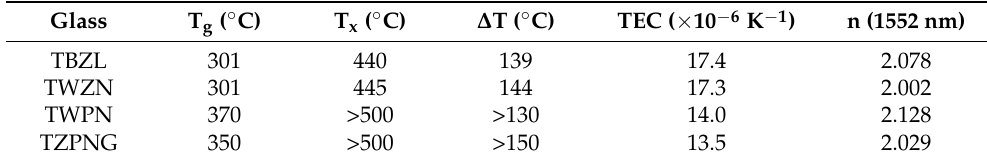
Table 2. Main thermal and optical properties of the fluorotellurite glasses.